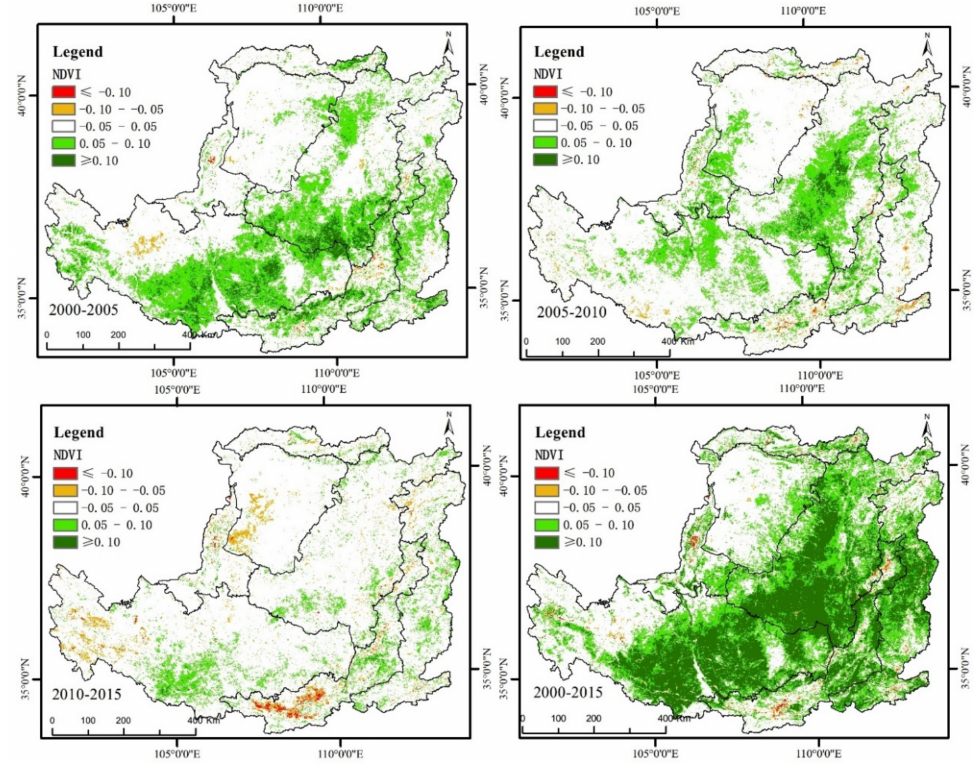
Figure 8. NDVI difference map of vegetation on the Loess Plateau in different periods of ecological